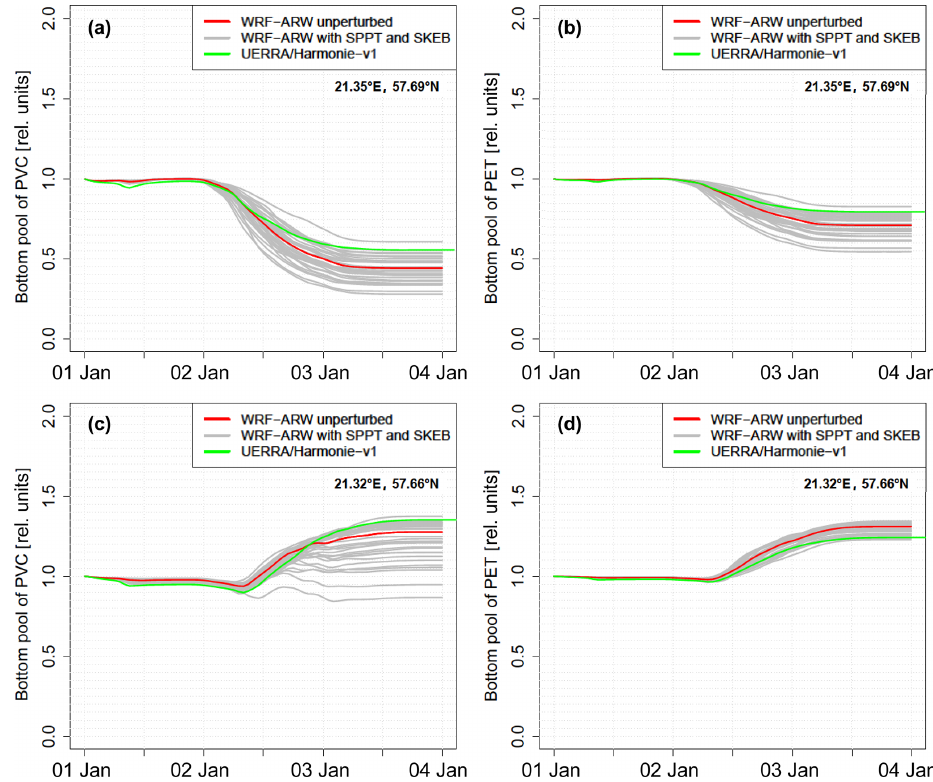
Figure 6. Changing bottom concentration of PVC (a, c) and PET (b, d) particles with a 330µm diameter in the two grid cells indicated in Fig. 5, relative to the initial concentration. The different curves show 30 perturbed runs and 1 unperturbed run with WRF atmospheric forcing and another simulation with UERRA/HARMONIE-v1 forcing. Panels (a) and (b) show a grid cell predominated by processes of net erosion, whereas panels (c) and (d) show a cell with net